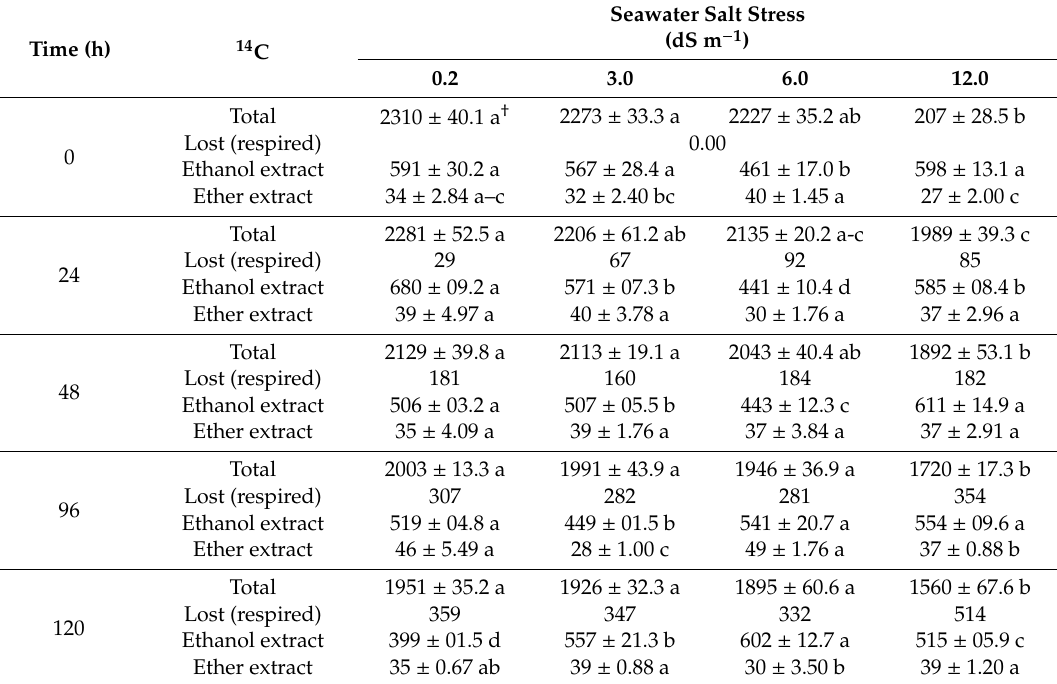
Table 1. Distribution of 14 C (Bq g − 1 DW) in ethanol-soluble compound and ether extract (lipid) of wheat plant leaves at 0, 24, 48, 96, and 120 h after subjecting wheat plants to 0.23, 3.0, 6.0, and 12.0 dS m − 1 salt stress for 21 days #